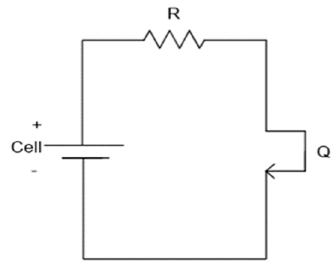
Figure 2. PEQ connections to a cell.